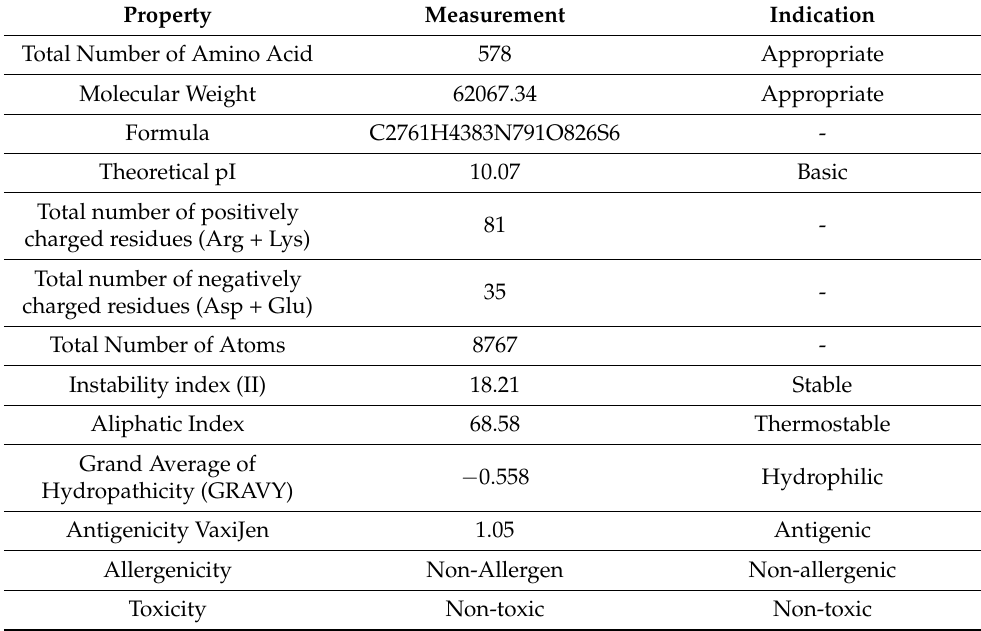
Table 1. Physiochemical analysis for multiple epitope vaccine construct